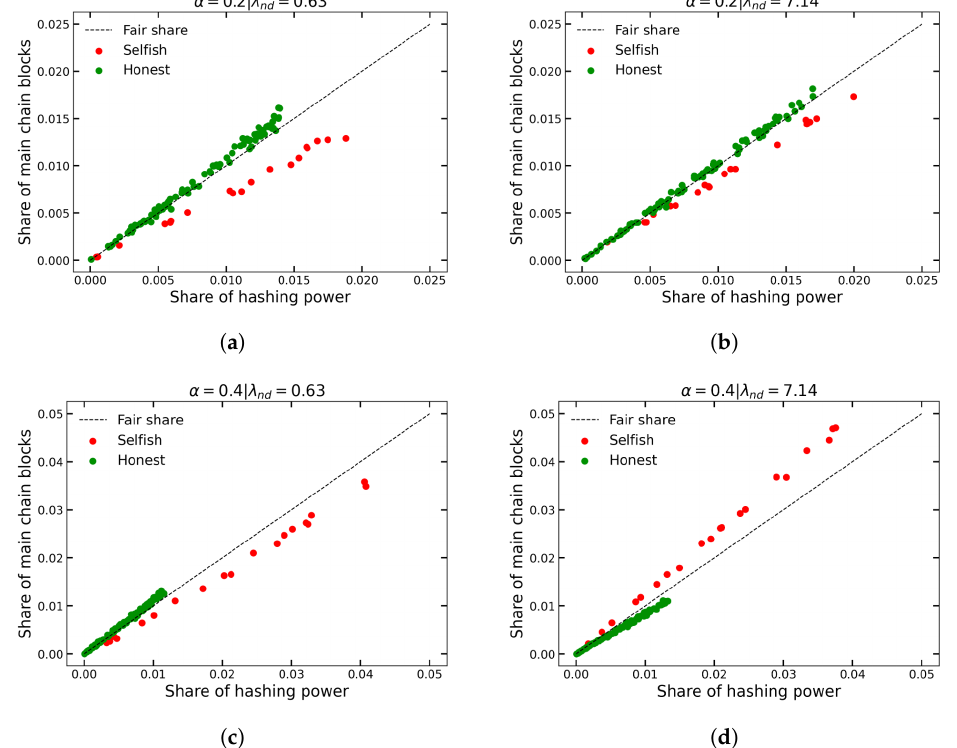
Figure 10. Single realisations for a selfish mining pool: Share of main chain blocks as a function of the share of hashing power for all nodes. In subfigures ( a , b ), all selfish miners in the mining pool control 20% hashing power, and in ( c , d ) those selfish miners control 40% hashing power. In addition, the subfigures in left column show the results when network has high latency λ nd = 0.63, and subfigures in right column show the results with low network latency λ nd =